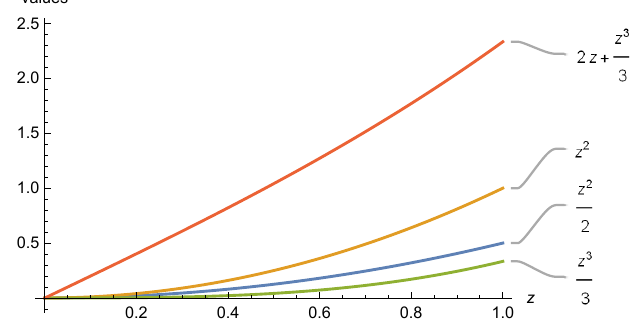
Figure 2. The graph shows the validity of Theorem 1.